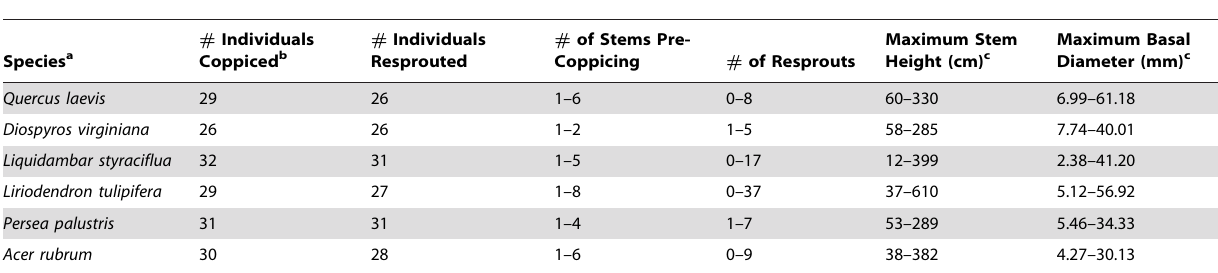
Table 1. General characteristics of individuals included in the study.